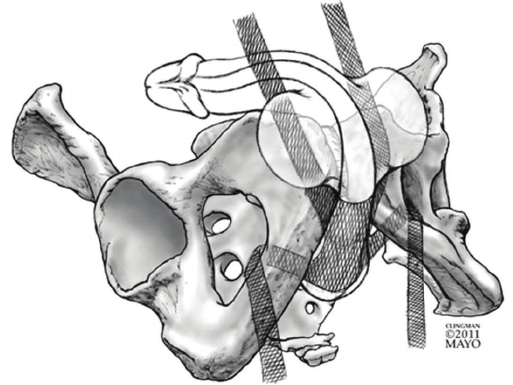
Figure 4: Graphical representation of the quadratic sling.